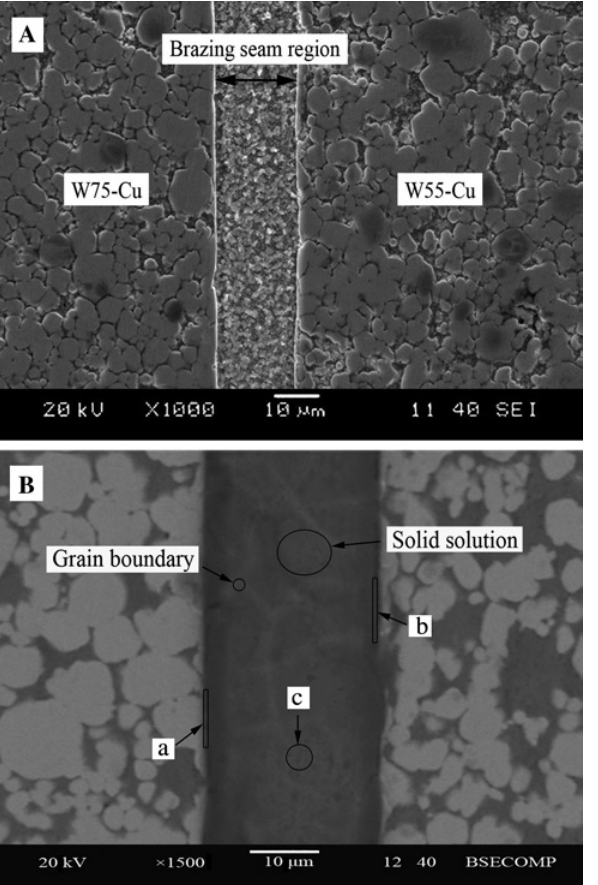
Figure 3: Microstructure and feature regions of the W75-Cu/W55-Cu brazed joint: (A) microstructure; (B) feature regions.